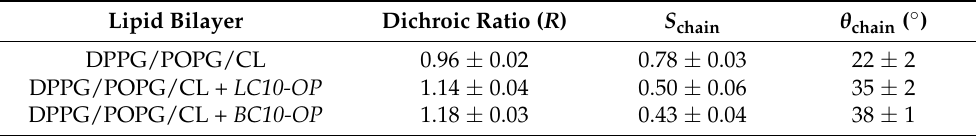
Figure 5. C–H stretching region of ATR-FTIR spectra recorded for DPPG/POPG/CL bilayer deposited onto the Si prisms after ~45 min of exposure to LC10-OP ( A ) and BC10-OP ( B ). The spectra were recorded in 0.01 M PBS dissolved in D 2 O. The red line corresponds to the spectrum recorded with p-polarized light, while the blue line corresponds to the spectrum recorded with s-polarized light. Table 3. Molecular ordering and orientation data a